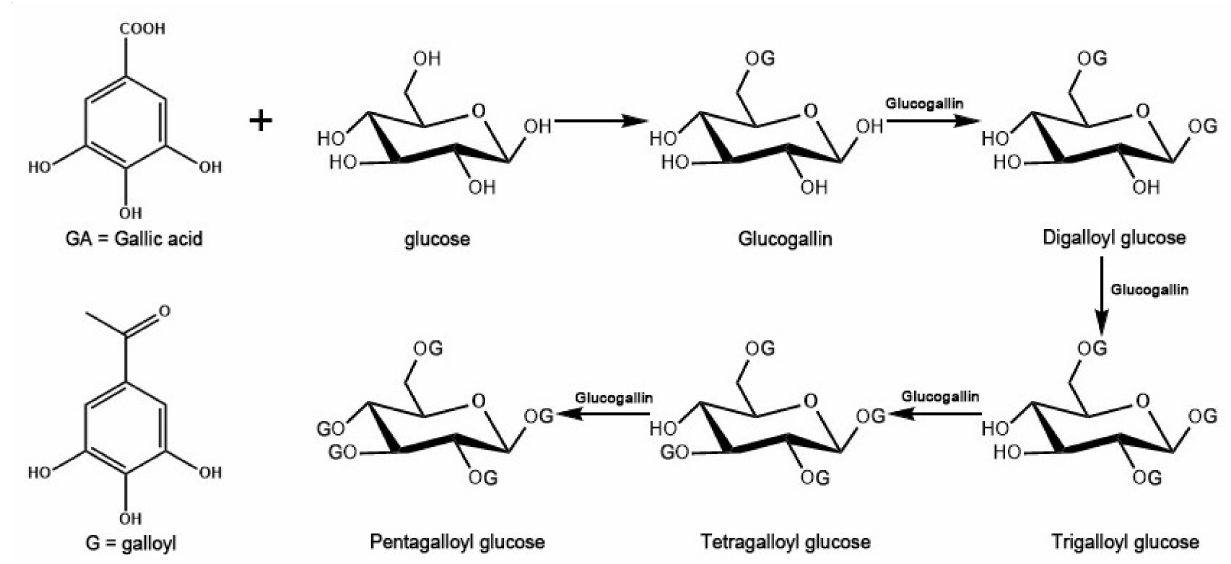
Figure 7. A schematic diagram describing the biosynthetic pathway of